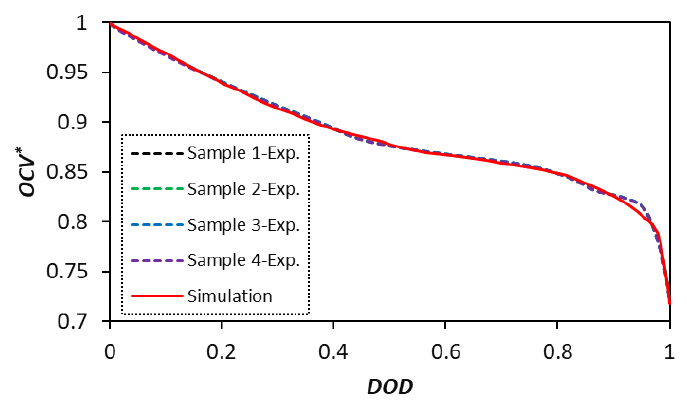
Figure 5. OCV calibration optimization results for the aggregate